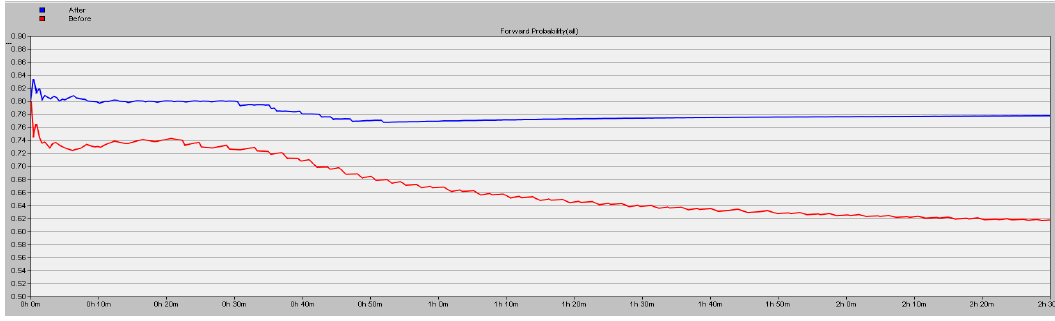
Figure 11. Forward probability of the network with three malicious nodes.